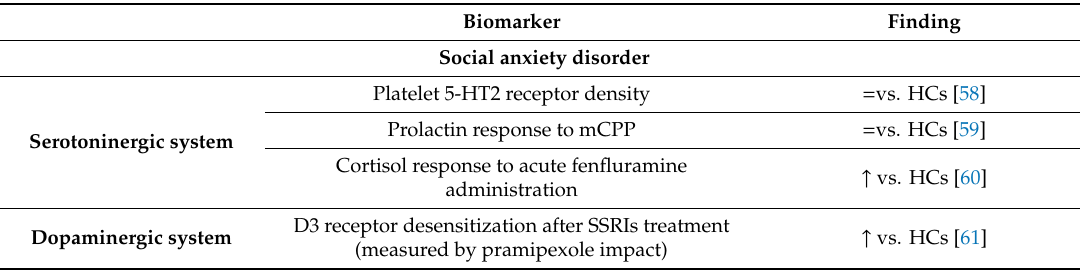
Table 1. Cont . Biomarker